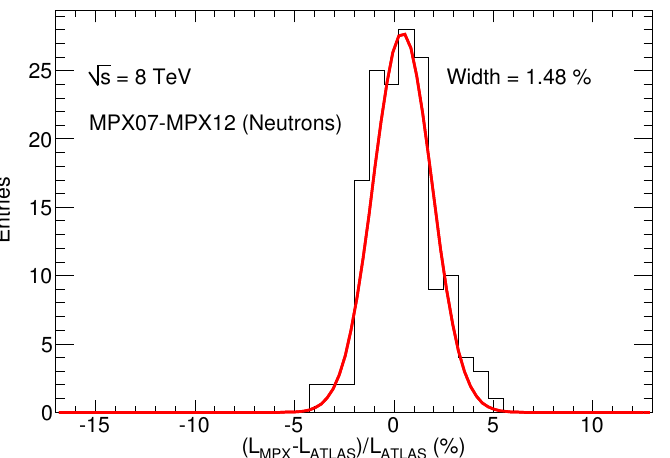
Figure 30. Residual distributions defined as ( L MPX − L ATLAS ) / L ATLAS . A Gaussian fit is applied. The MPX neutron luminosity is normalized to the MPX hit luminosity [11] such that their ratio for the data (as defined in the text) taken on 16 September 2012 is unity. The data of the devices MPX07-MPX12 are combined. Taken from Ref.